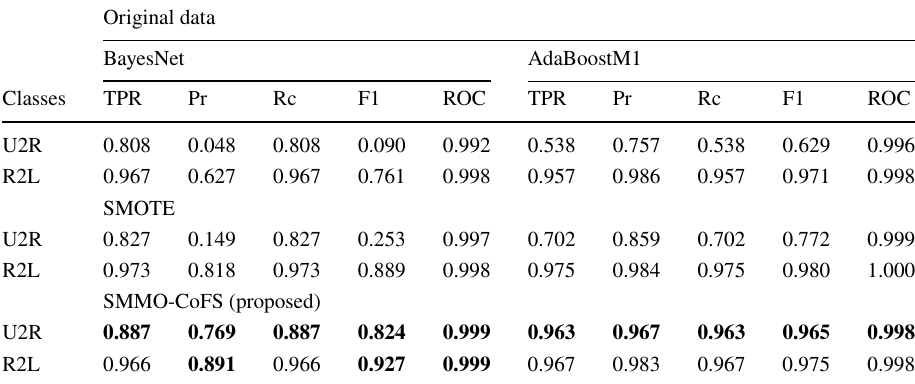
Bold values indicate the best results obtained for